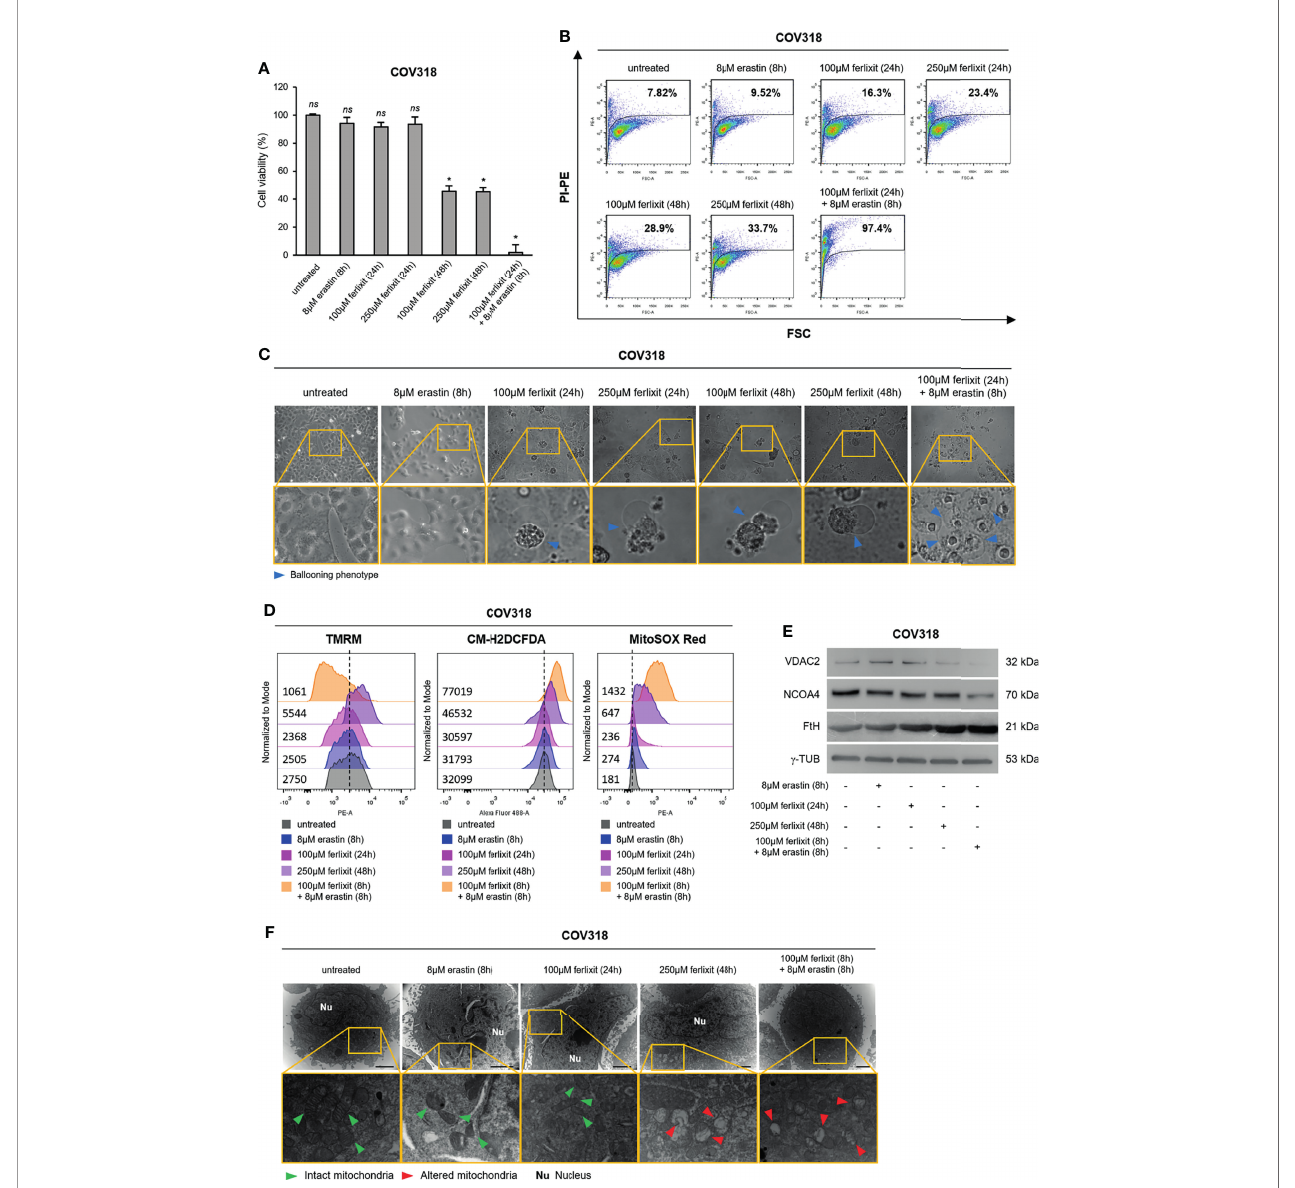
FIGURE 5 | Ferlixit/erastin co-treatment leads to ferroptosis in COV318 cells. COV318 cells were treated with different concentrations (100 and 250 µM for 24 and 48 h) of ferlixit alone or in combination with 8 µM erastin for 8 h. Cell viability and mortality were measured using the MTT assay (A) and the PI fl ow cytometry assay (B) , respectively. Results are shown as means±SD of three independent experiments. * p -value <0.05, untreated vs treatment; ns, not signi fi cant. (C) Optical microscopy images showing the presence or absence of the ballooning phenotype in COV318 cells upon treatment with ferlixit and erastin alone or in combination. (D) Analysis of mitochondrial membrane potential, cytosolic and mitochondrial ROS production by TMRM, CM-H2DCFDA and MitoSOX Red fl ow cytometry assays in COV318 cells untreated, treated with ferlixit and erastin alone or in combination. (E) Western Blot of VDAC2, NCOA4, and FtH in COV318 cells upon administration offerlixitanderastin aloneorin combination. g -TUBwas used as a normalization control for protein quanti fi cation. (F) Mitochondrial ultrastructural images detected byTEM in COV318 cells upontreatment with ferlixitandferlixitalone or incombination. Green arrows, intact mitochondria; red arrows, alteredmitochondria; Nu,nucleus. Alldata are representative of three independent